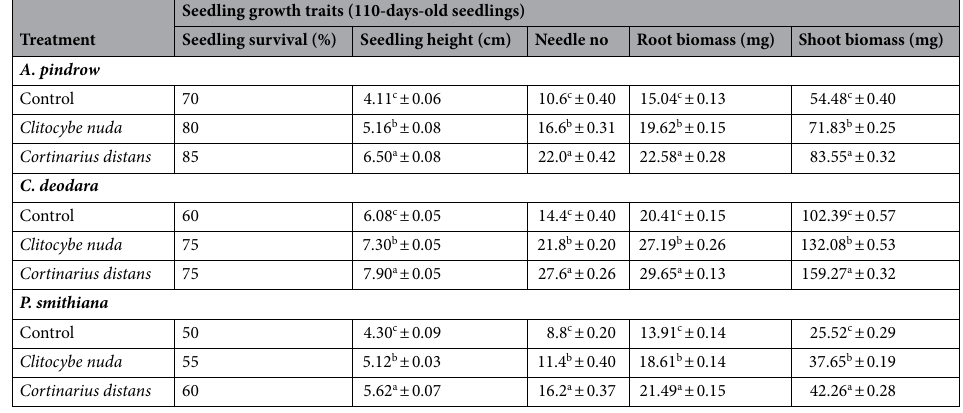
Table 1. Effect of ECM inoculation on seedling growth traits (mean ± SE) in A. pindrow , C. deodara , and P. smithiana under greenhouse conditions. Mean values between rows (treatments) separated by different letters are significantly different ( P < 0.05) according to Tukey’s test.